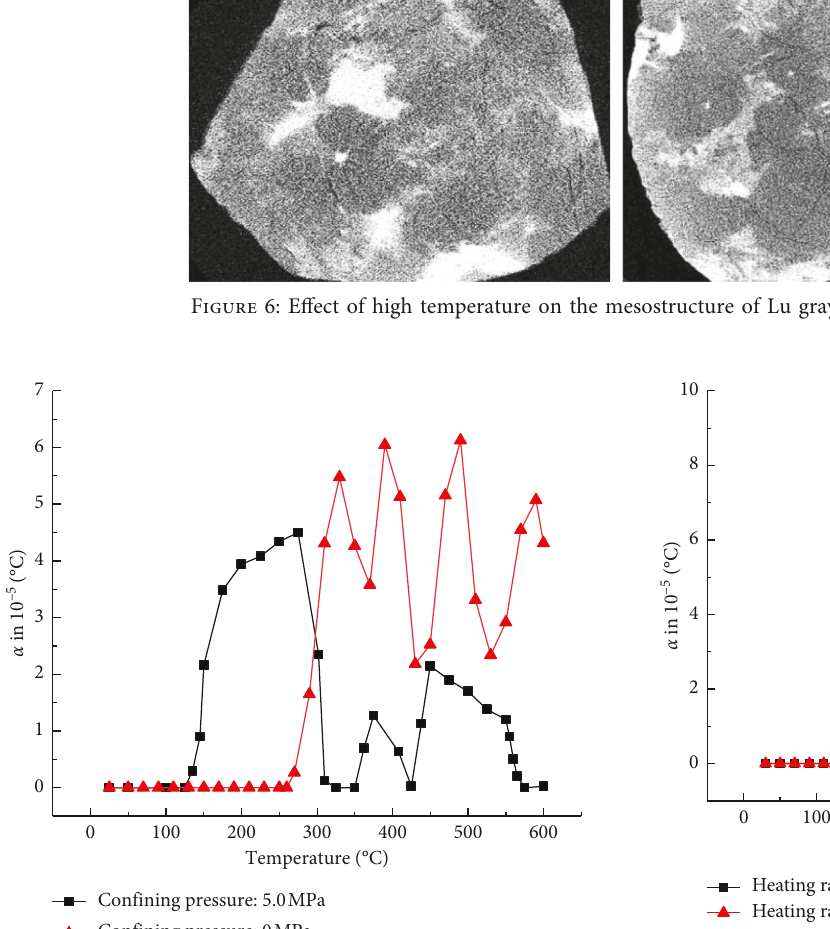
Figure 7: Thermal expansion coefficient ( α ) change versus tem- perature under different confining pressures.